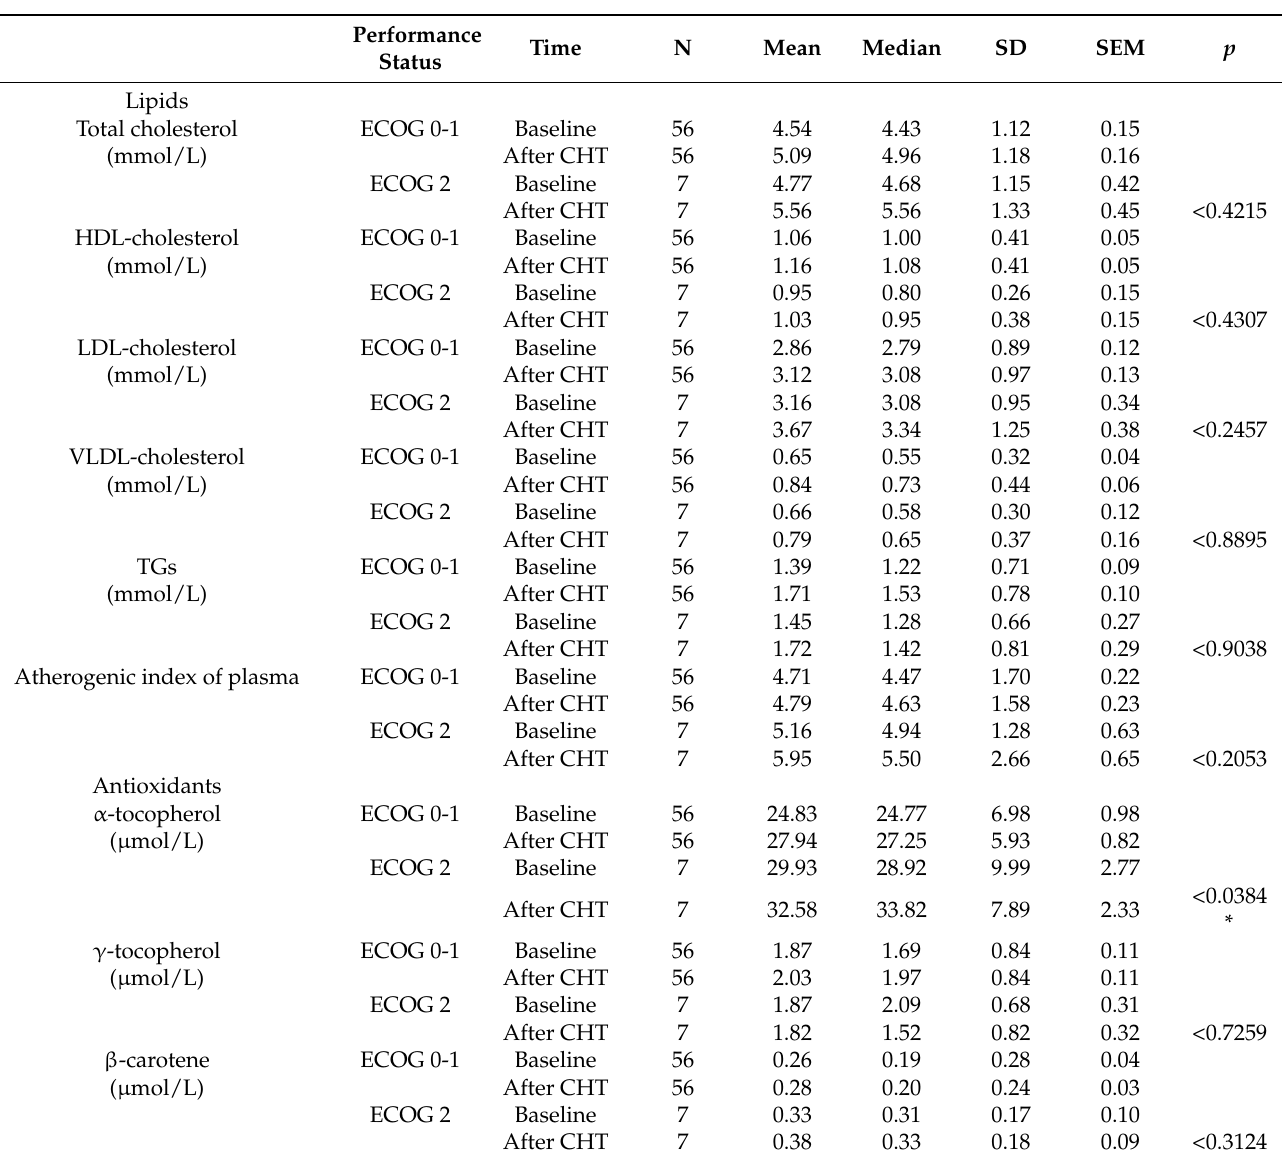
Table 2. Plasma lipids, antioxidants, index CoQ 10-TOTAL /lipids, and oxidative stress baseline vs. after two courses of chemotherapy in metastatic urothelial carcinoma (mUC) patients—a subgroup